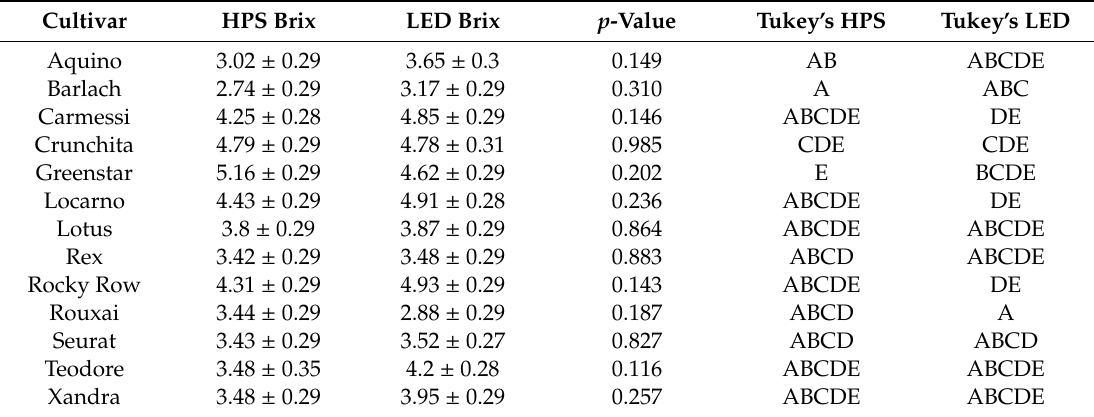
Table 5. Brix ( ◦ ) of 13 cultivars of lettuce in phase 1 in which plants were grown under HPS or